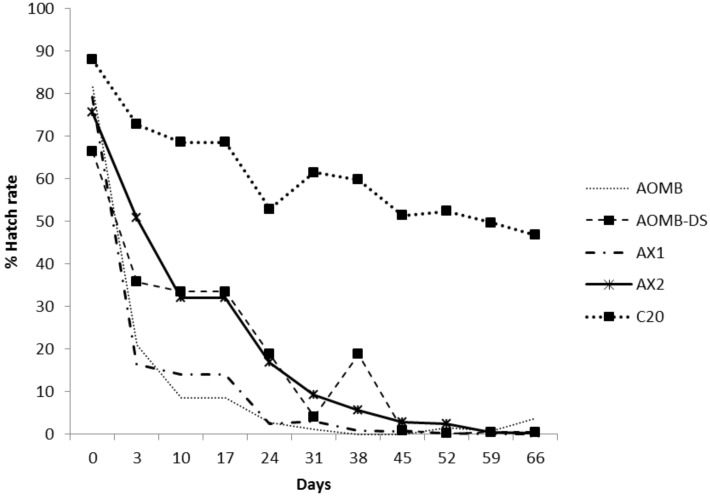
Changes in the hatch rates of the lines when eggs are maintained in a quiescent stage for different lengths of time before being hatched.An uninfected line (C20; top line) was included as a control. The other lines are the infected wMelPop line (AOMB), the same line after four rounds of selection (AOMB-DS), and backcross lines to place the wMelPop infection from the selected line onto the nuclear background of the unselected line (AX1) or the infection from the unselected line onto the nuclear background of the selected line (AX2).